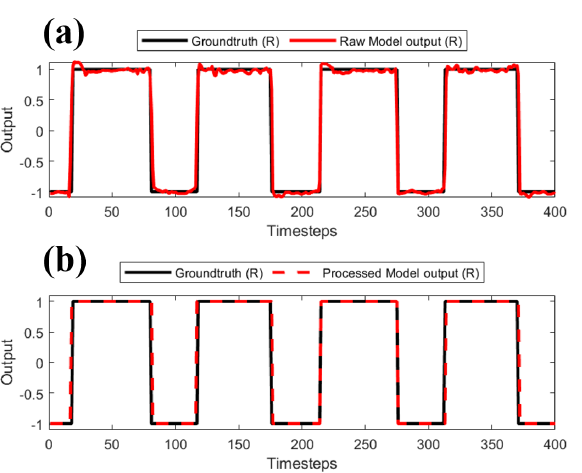
Figure 6. Groundtruth compared to ( a ) pre-processed output signal and ( b ) post-processed out- put